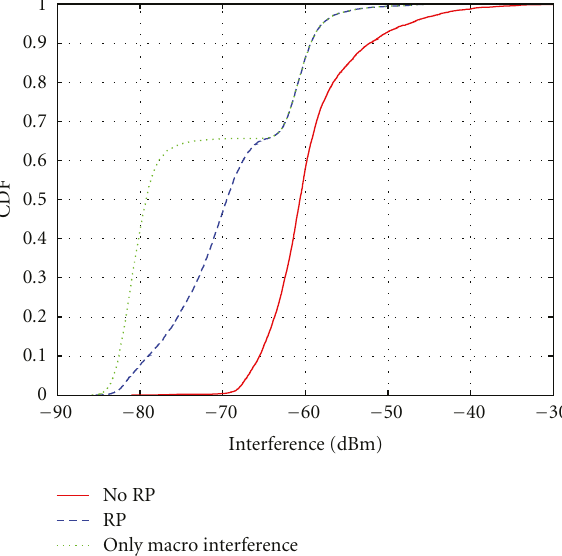
Figure 5: CDFs showing downlink interference for a ff ected macro UEs in systems with and without resource partitioning, compared against a system with no femto